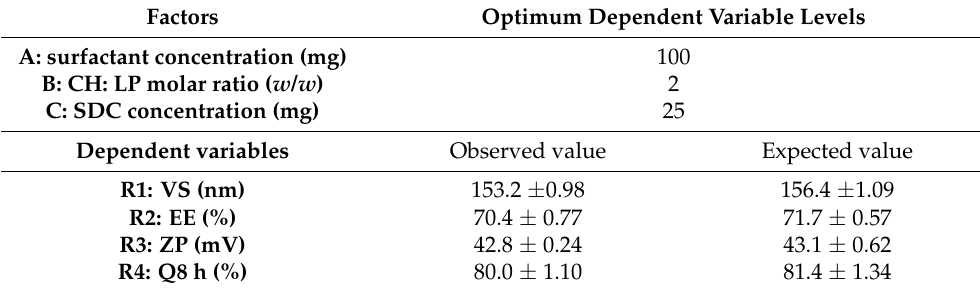
Table 4. Optimum levels of independent variables of the suggested LUT BL (BL4) with the expected and observed dependent